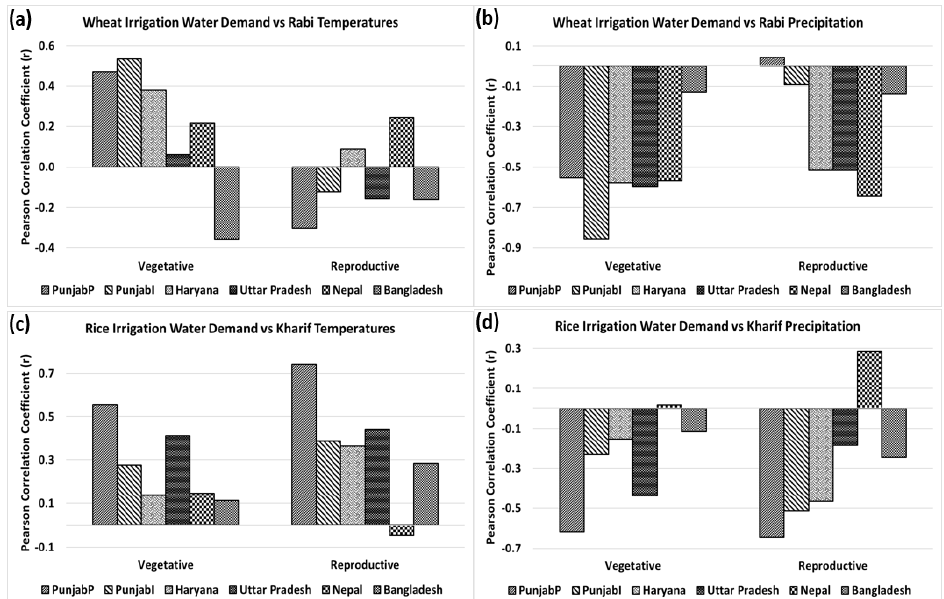
Figure 4. Time series correlation of phenological phase specific irrigation water demand with temperature and precipitation in all selected study sites during period 1981–2010. The upper panels ( a , b ) show the correlation bars of irrigation water demand with temperature ( a ) and precipitation ( b ) during the vegetative and reproductive phase of wheat crop in rabi season. Panels ( c , d ) show the correlation bars of irrigation water demand with temperature ( c ) and precipitation ( d ) during the vegetative and reproductive phase of rice crop in kharif season.